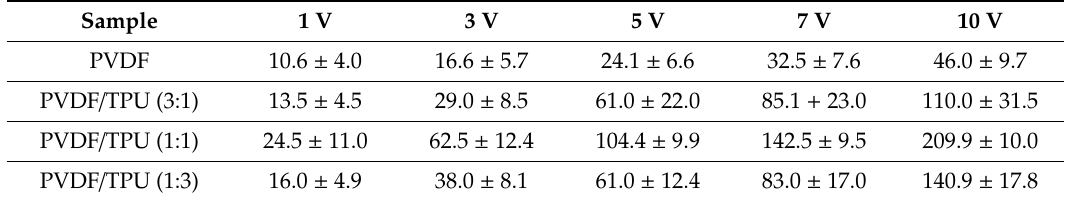
Figure 12. PFM Height retrace at 10 V applied potential for di ff erent PVDF / TPU blend ratios. ( a ) PVDF, ( b ) PVDF / TPU (3:1), ( c ) PVDF / TPU (1:1), and ( d ) PVDF / TPU (1:3). Table 4. Mean Amplitude Retrace (in pm) for Di ff erent PVDF / TPU Nanofibrous Composite Membranes at Di ff erent Applied Voltages.